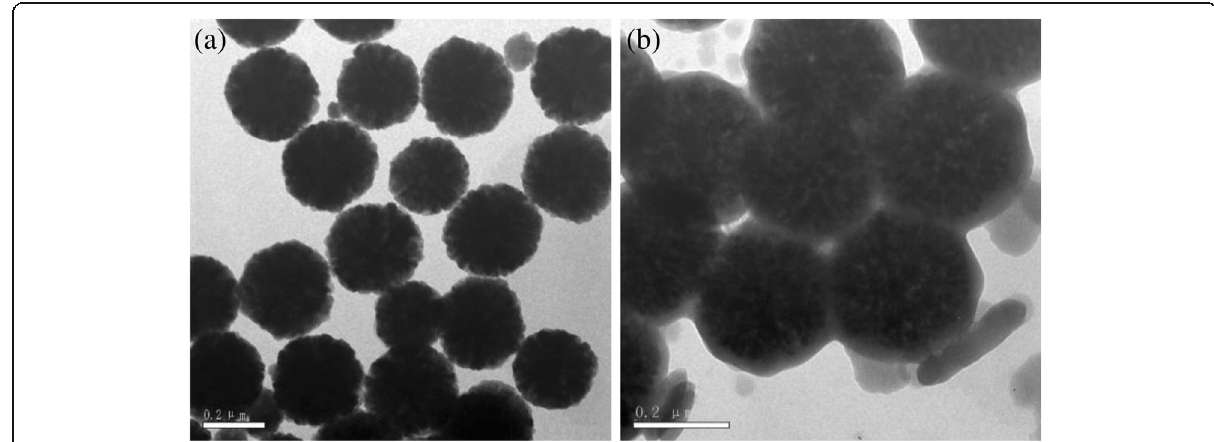
Fig. 1 TEM images. a Fe 3 O 4 nano/microspheres. b MCMs